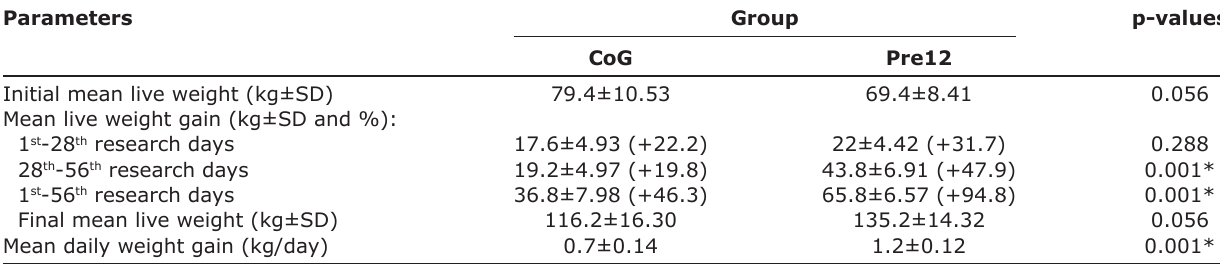
Table-2: Growth performance of calves. Parameters